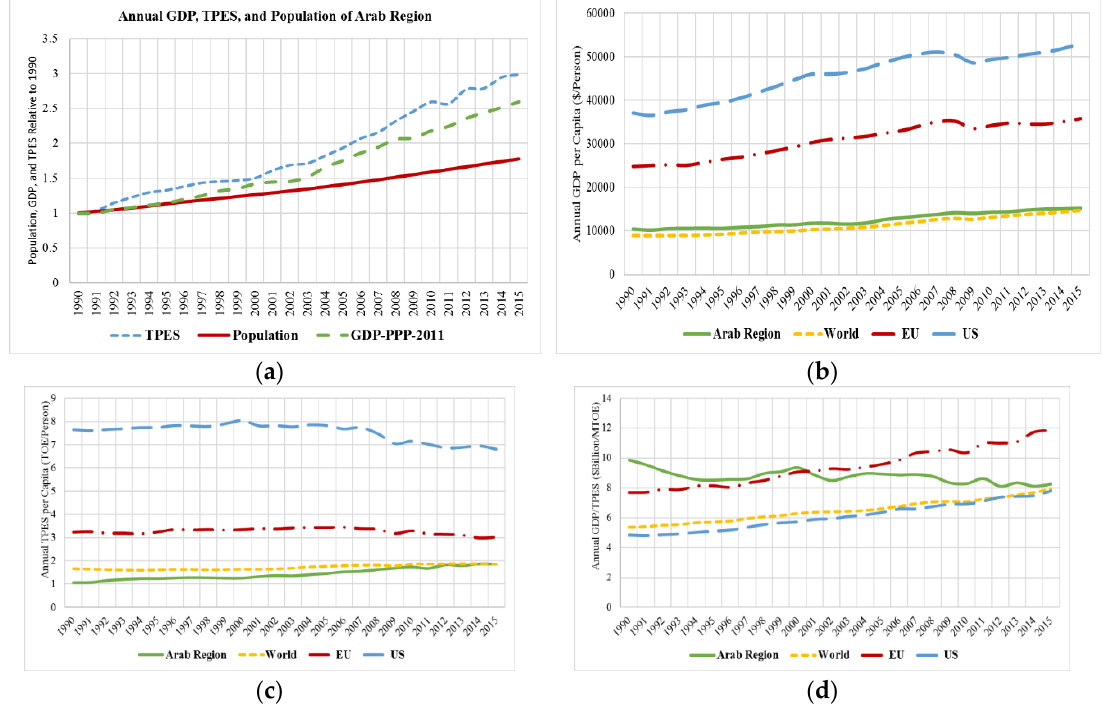
Figure 1. Annual variation gross domestic product (GDP), Total primary energy supply (TPES), and population of the Arab region compared to those of US, EU, and World. ( a ) GDP, TPES, population index to 1990; ( b ) per capita GDP; ( c ) per capita TPES; ( d ) GDP per TPES (Data Source: International Energy Agency (IEA) [1]).